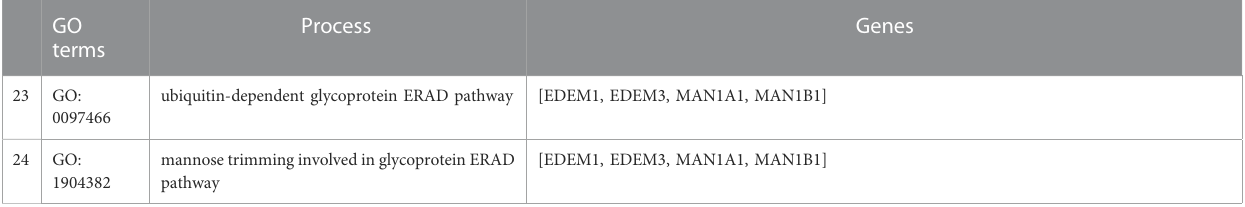
TABLE 2 ( Continued ) Gene ontology (GO) processes identi fi ed for the 58 upregulated ER stress- and UPR-related genes from the human Affymetrix chip analysis with p-adjusted (BH) < 0.1. The ontology analyses for all the differentially expressed genes were performed in ClueGO in Cytoscape. No signi fi cantly enriched ER stress- and UPR-related processes were identi fi ed with downregulated